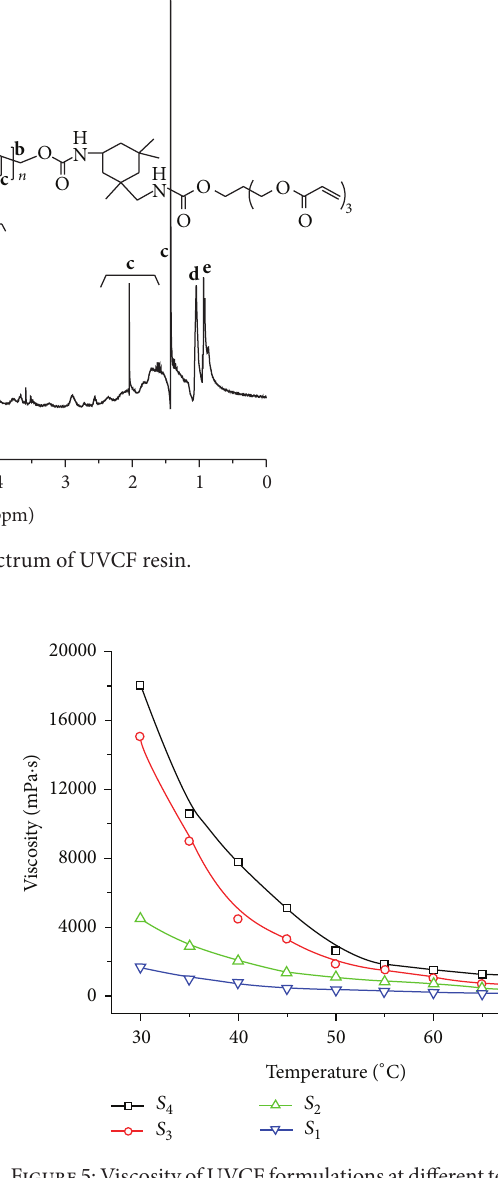
Figure 5: Viscosity of UVCF formulations at different